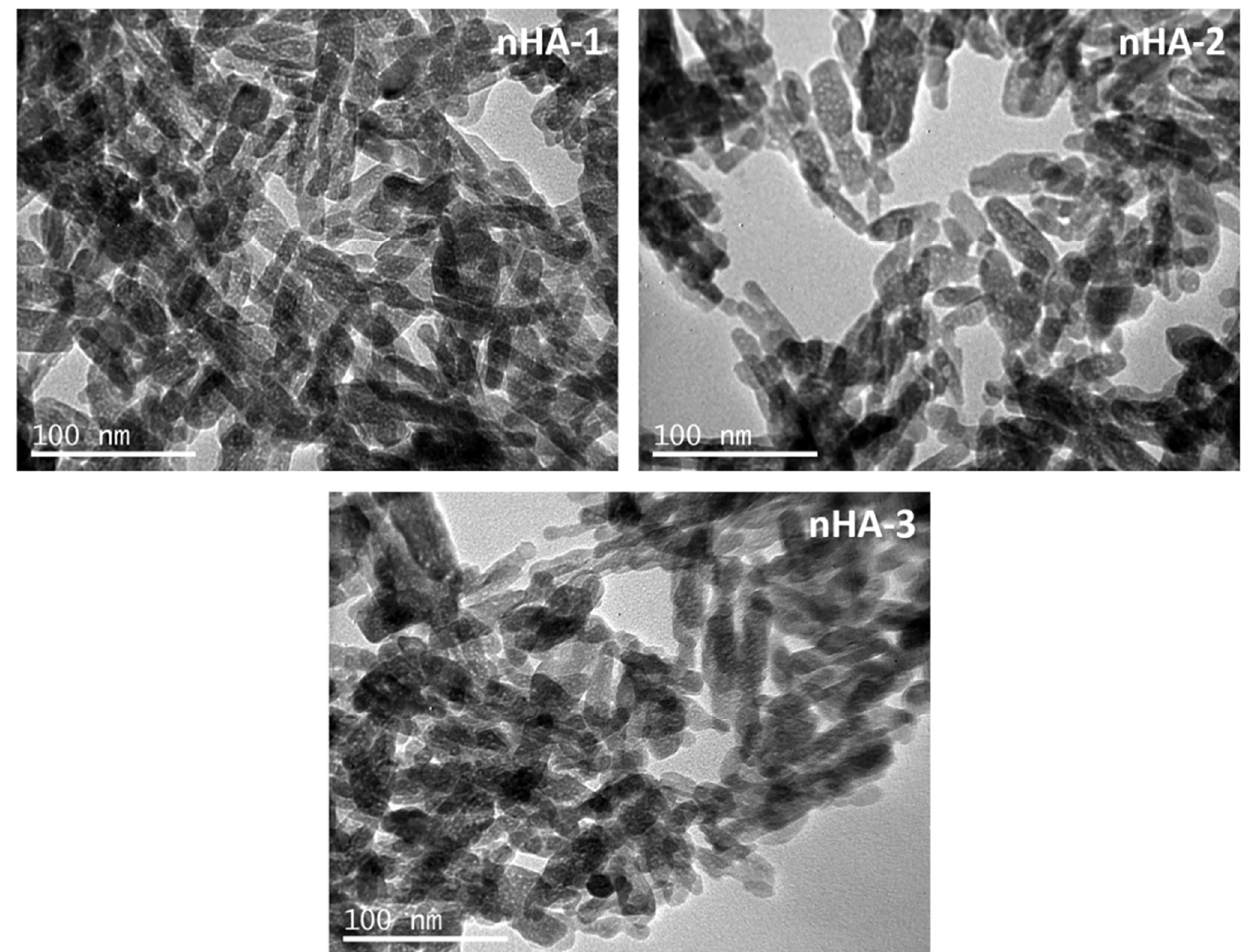
Figure 1 . Transmission electron microscopy images from nHA-1, -2 and -3 indicating a rod-like shape of an average length of approximately 20 to 40 nm. The scale bar represents 100 nm.